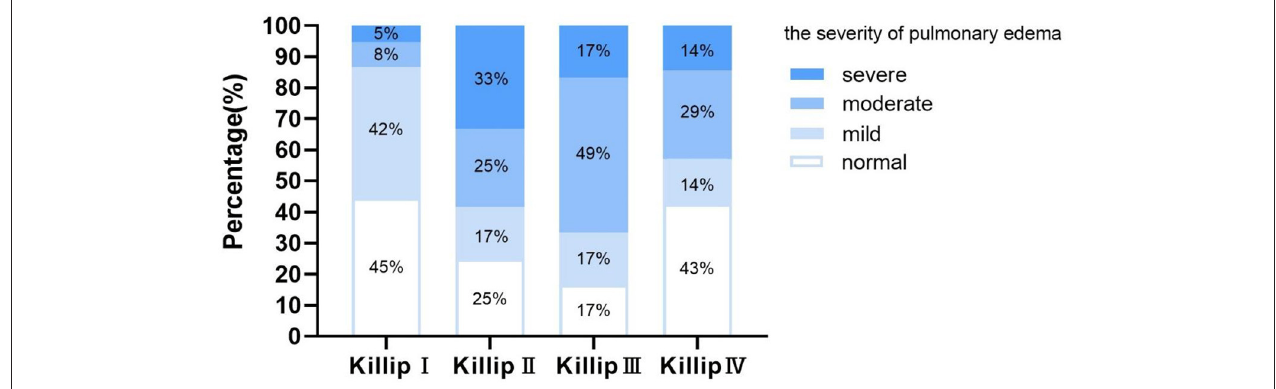
FIGURE 2 | Proportion of the severity of lung water in patients with Killip I–IV. Normal, B-line numbers < 5; Mild, B-line numbers ≥ 5 and < 15; Moderate, B-line numbers ≥ 15 and < 30; Severe, B-line numbers ≥ 30.